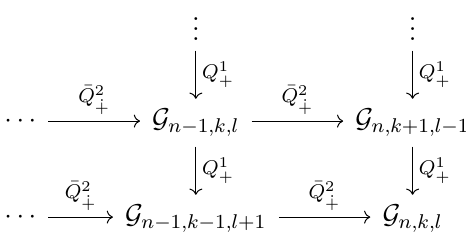
Figure 3 . Double complex formed by quasi-chiral operators with s = − 1